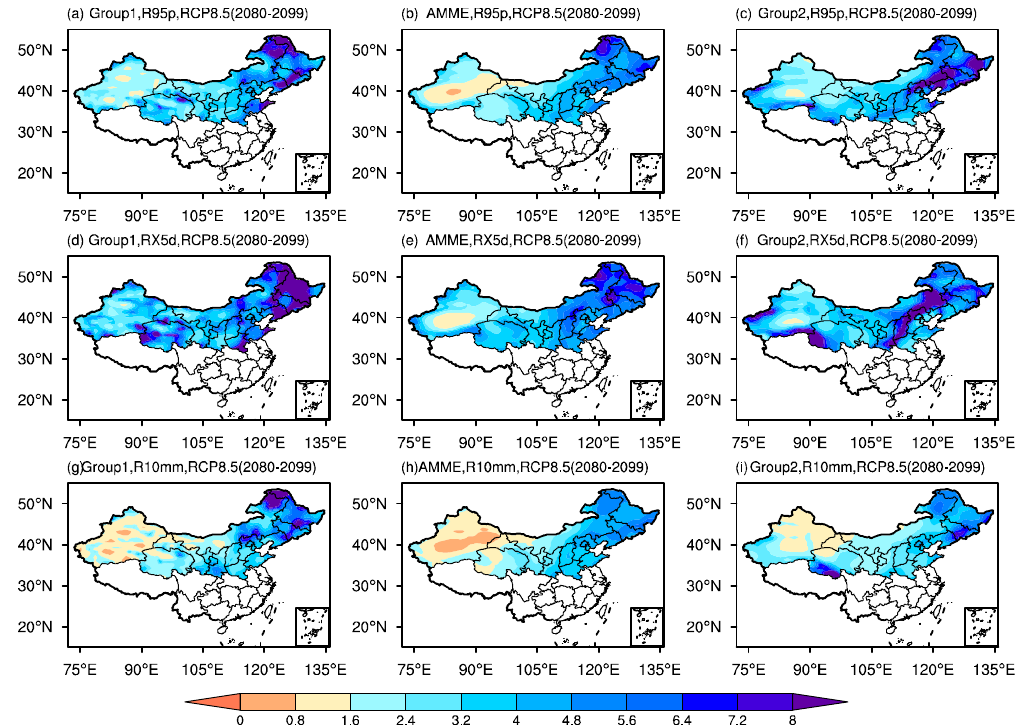
Figure 12. The spatial pattern of SNR for R95P ( a – c ), RX5d ( d – f ), and R10mm ( g – i ) from Group 1, AMME, and Group 2 under RCP 8.5 at the end of the 21st century (2080–2099).